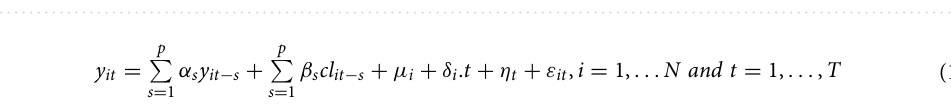
Figure 1. Comparison of the time series of total hospitalizations and deaths and the average IPTCC, March 23, 2020 to January 10,